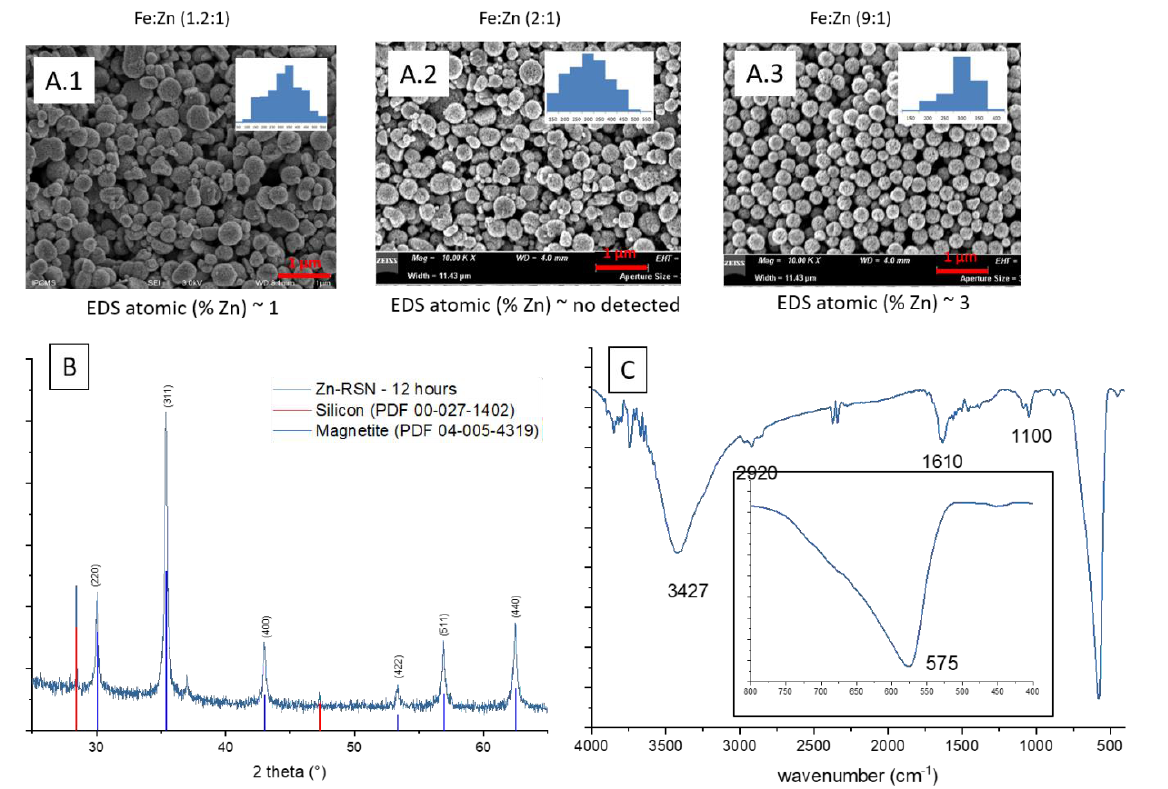
Figure 3. (A.1 – A . 3 ) SEM images of all zinc-doped RSNs (inner image: size distribution); ( B ) XRD pattern; ( C ) IR spectrum of zinc-doped RSNs (9:1) (mixing time: 3 h; reaction time 12 h) (inner image: zoom on the Fe – O band characteristic of slightly oxidized